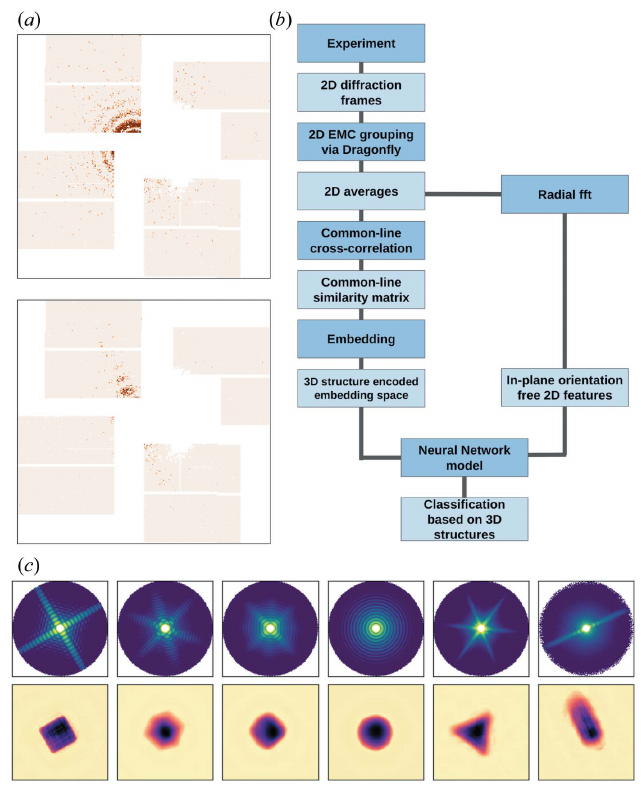
Figure 1 ( a ) Examples of diffraction patterns in the data set. The colour scale maximizes at four photons. ( b ) The workflow of the CLPCA method. ( c ) The upper row shows some typical frame averages in the dataset on a logarithmic scale, while the lower row shows their corresponding real- space 2D density projections via phase retrieval. The real-space field of view is 132.4